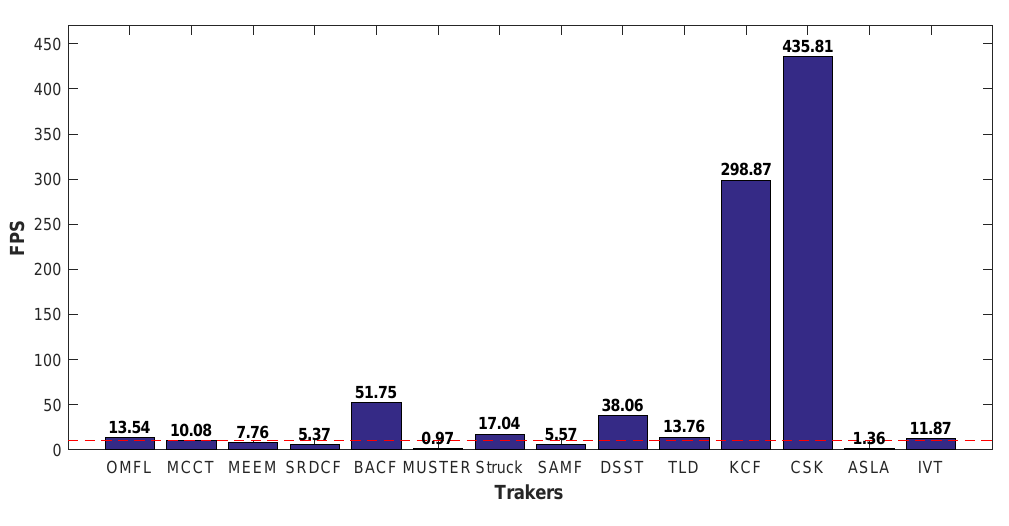
Figure 16. FPSs of all trackers on 123 challenging UAV image